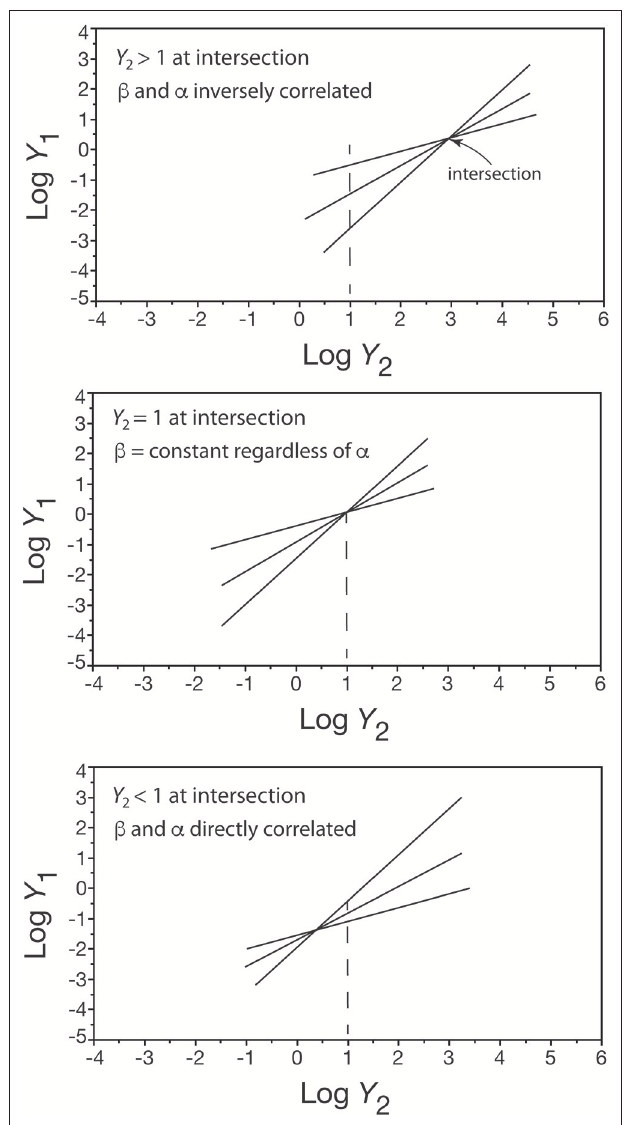
FIGURE 4 | Three bivariate plots showing how the placement of a shared point of intersection in a set of log-log linear scaling relationships (only three are shown for convenience) affects whether β and α are inversely correlated ( top ), not correlated ( middle ), or directly correlated ( bottom ). See text for